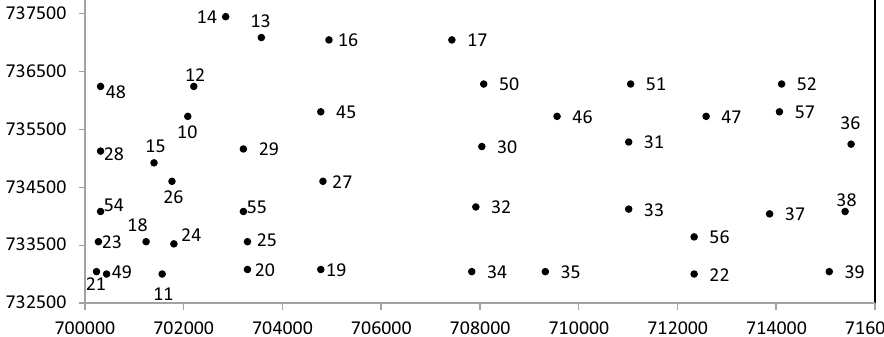
Fig. 3 X–Y coordinates of the locations of the wells drilled in the study area. Adapted from Falebita et al.